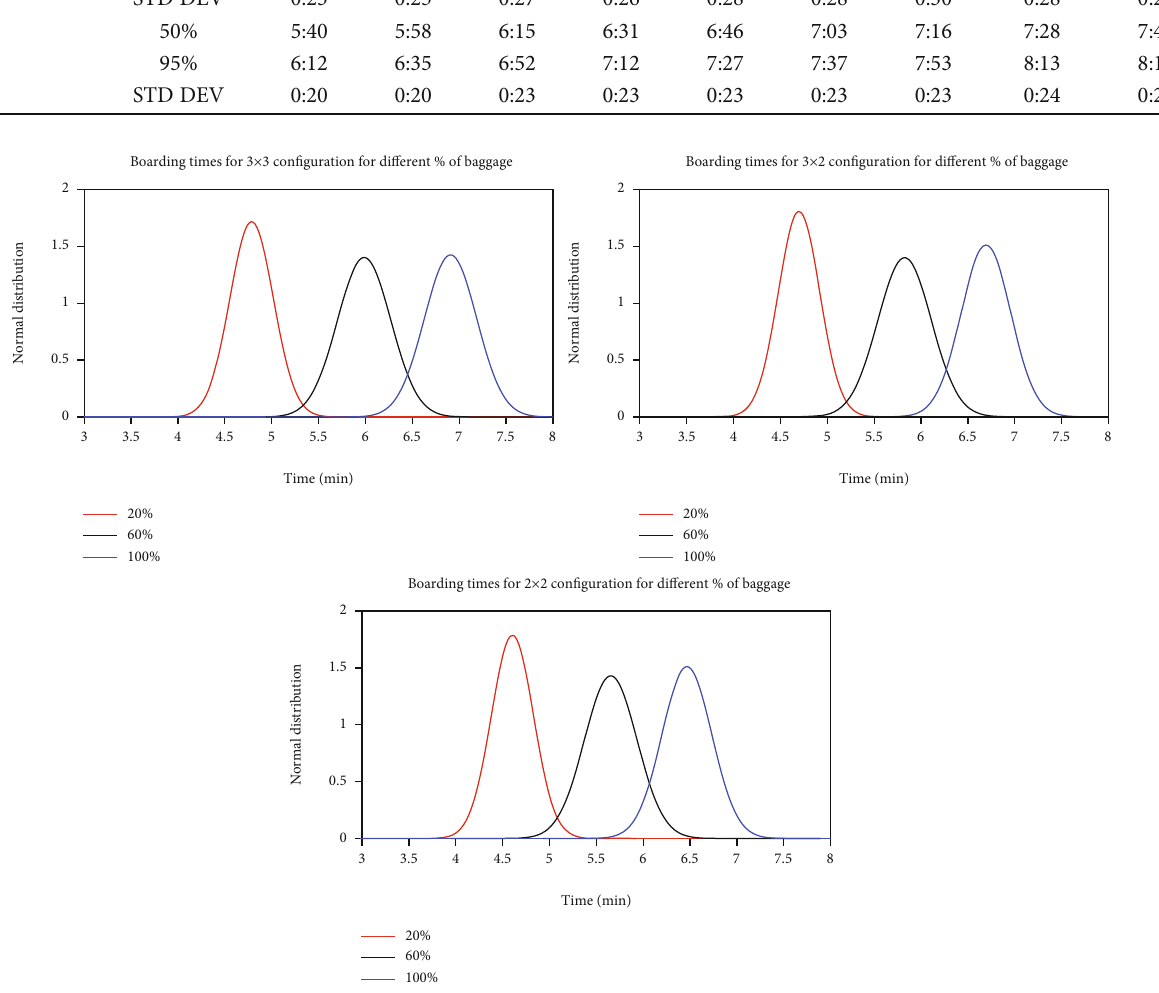
Table 9: Complete comparison of boarding times for the three aircraft con fi gurations using the random boarding strategy for di ff erent % of carry-on baggage. Con fi